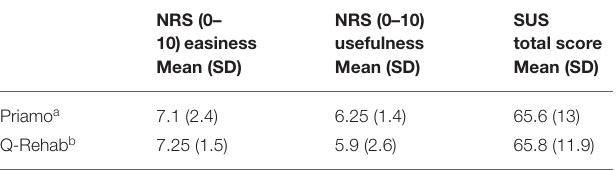
TABLE 3 | Staff satisfaction in the use of the